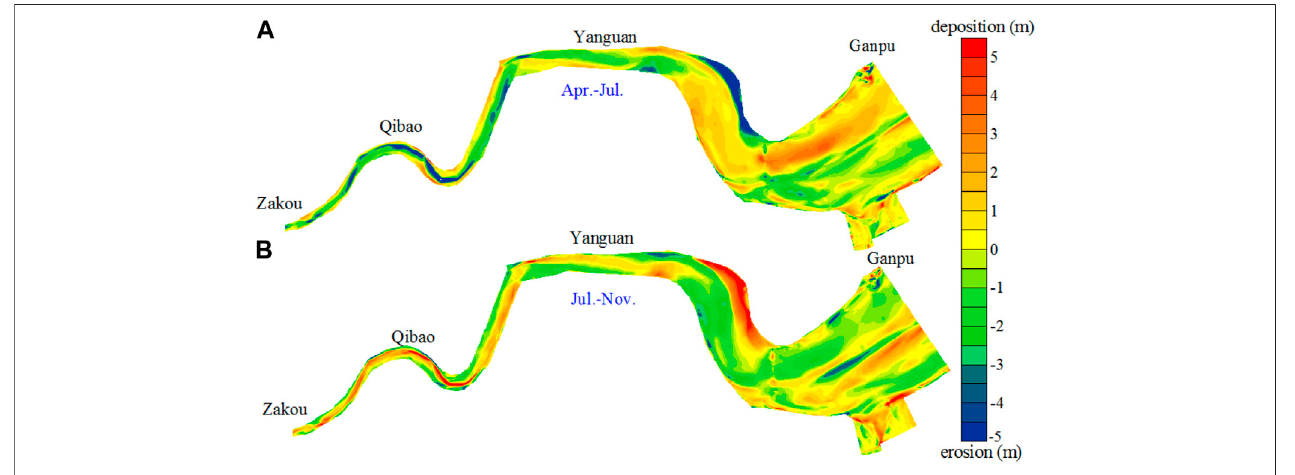
FIGURE 4 | Bed erosion and accretion patterns from april to July (A) and from July to November (B) in 2015 (after Xie et al., 2018).